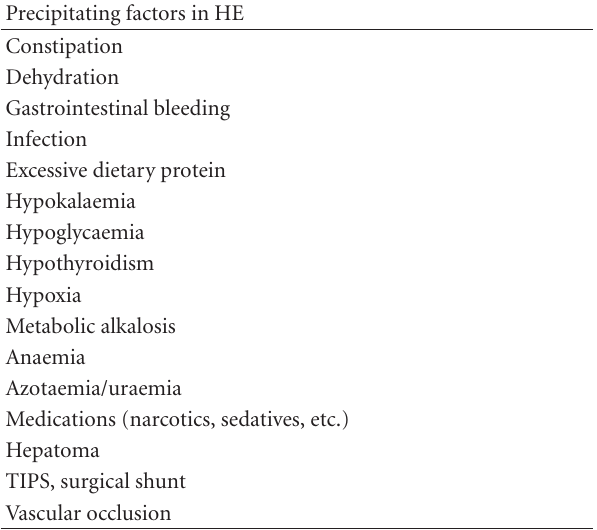
Table 2: Precipitating factors in hepatic